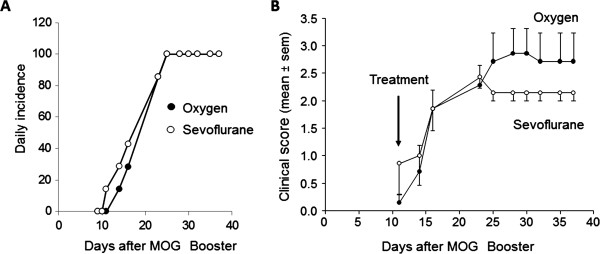
Sevoflurane attenuates development of clinical scores in experimental autoimmune encephalomyelitis (EAE). Female C57Bl/6 mice were immunized with myelin oligodendrocyte glycoprotein (MOG)35–55 peptide to develop EAE as described in the Methods section. At 10 days after the MOG booster, the mice were subjected to 2 h of 2.5% sevoflurane in 100% oxygen (open circles), or 100% oxygen alone (filled circles). Clinical scores were monitored for the next 4 weeks. (A) Daily incidence of disease over the course of the study for both groups. (B) Mean ± SEM of average clinical scores of one experiment performed with n = 7 mice per group; similar results were obtained in a second independent study. F[9,1] = 1.98, P = 0.049, two-way repeated measures analysis of variance (ANOVA).